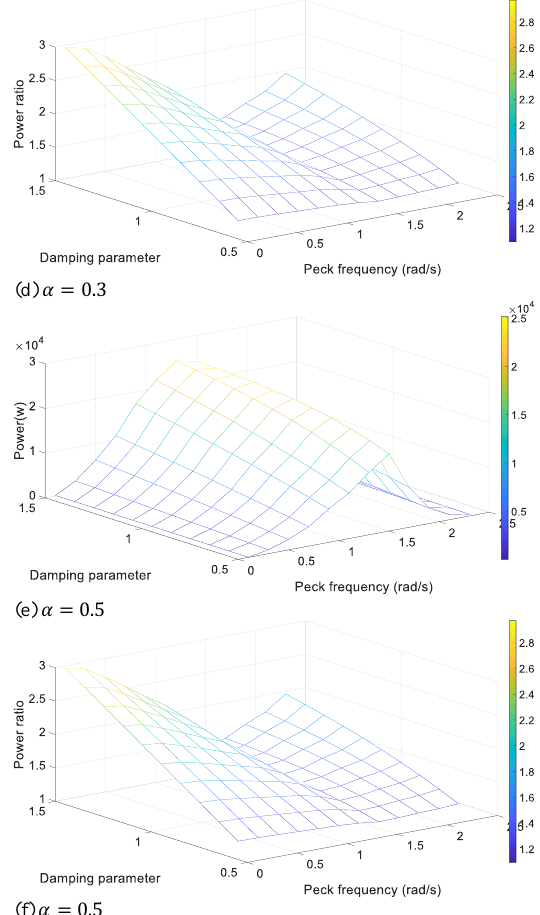
Fig. 8. The power and power ratio of WEC in different peak frequencies and damping parameter with the different nonlinear parameters (a) (b) 𝛼 = 0.1 ; (c) (d) 𝛼 = 0.3 ; (e) (f) 𝛼 = 0.5